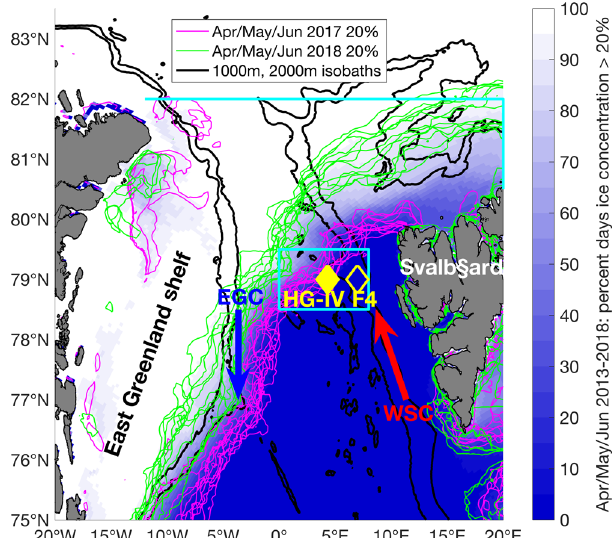
Fig. 1 Map of mooring locations, major currents, and ice coverage in Fram Strait. The percentage of days in April/May/June 2013 – 2018 during which sea ice cover exceeded 20% is shown in white-blue. The width of the marginal ice zone (20% contour to 80% contour) was typically less than 50 km. The weekly 20% sea ice concentration contours for the study period in April/May/June are shown in magenta (2017) and green (2018). The meltwater regime typically applies in the area covered by the variability of the 20% contours. The mixed layer regime by contrast applies well east/ south (~50 – 100 km) of the 20% contours. Thus mooring HG-IV is in the meltwater regime in 2017 and in the mixed layer regime in 2018. The major currents in the area are indicated schematically: West Spitsbergen Current (WSC) and East Greenland Current (EGC). The location of the moorings discussed in this study are marked in yellow: F4 in the WSC (data shown in Figs. S1 – S3) and HG-IV west of the WSC (data shown below). The 1000-m and 2000-m isobaths are shown in black and land in gray. The gate and box used in Figs. 2 and 9, respectively, are shown in